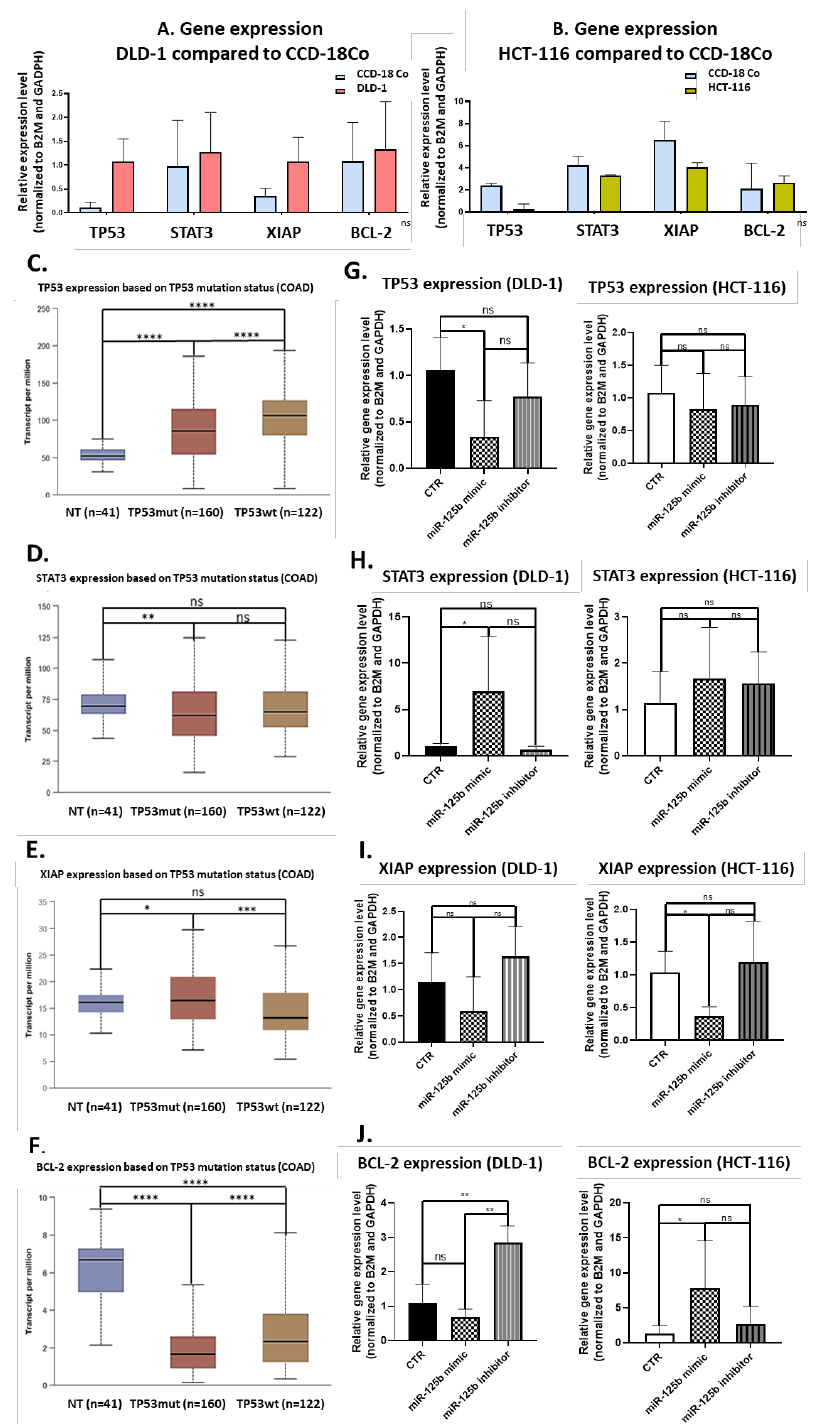
Figure 7. miR-125b-gene interaction network and its changes in colon cancer following miR-125b exogenous modulation. ( A ) RT-qPCR expression of TP53, STAT3, XIAP, and BCL-2 in DLD-1 (colon cancer) compared to CCD-18 cell line